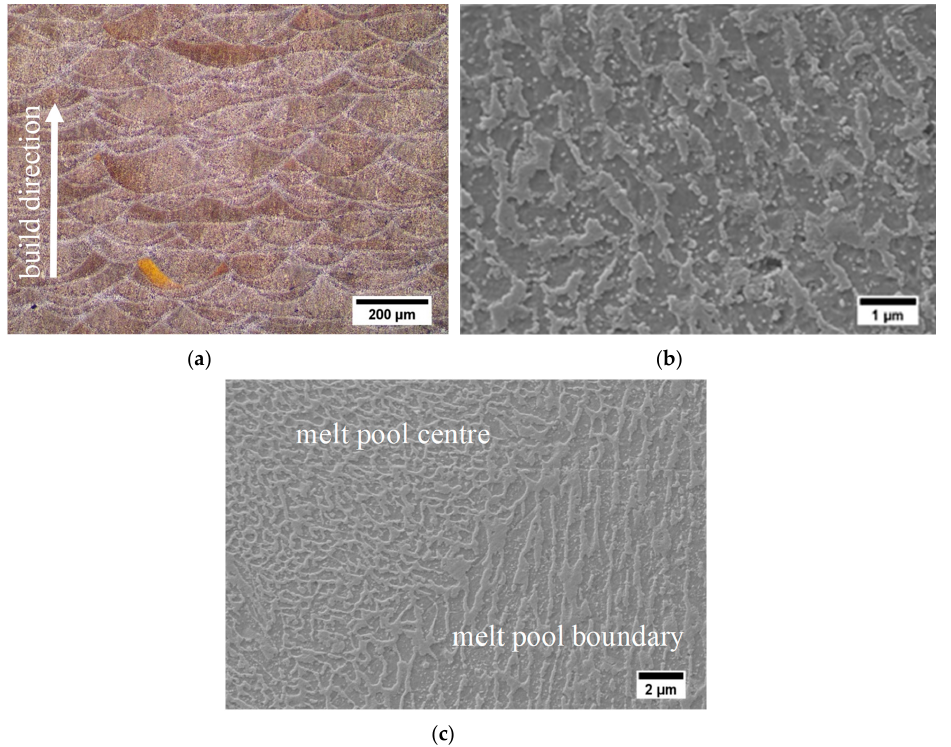
Figure 2. Microstructure of the investigated AlSi10Mg alloy. ( a ) Optical image of the melt tracks; ( b ) scanning electron microscope (SEM) image of the melt pool boundaries, and ( c ) of the melt pool